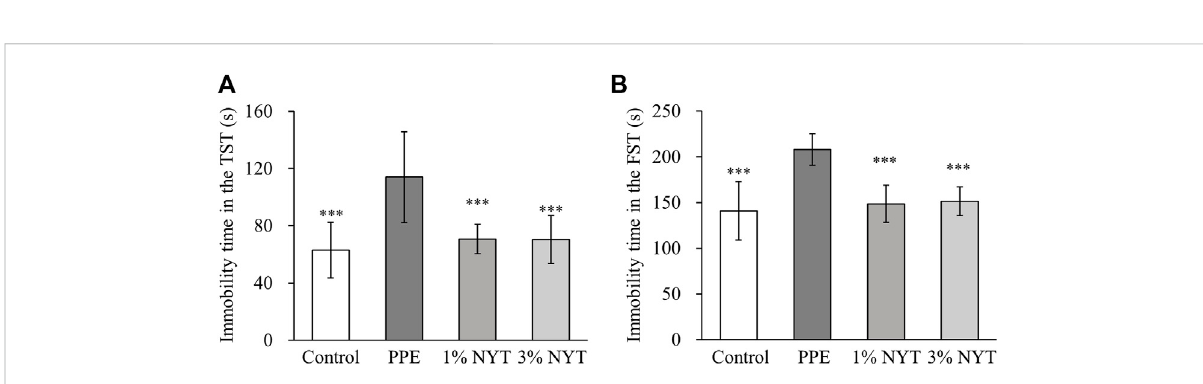
FIGURE 6 Effect of ninjin ’ yoeito (NYT) on PPE-induced depression-like behaviors. (A) Immobility time in the TST(s). (B) Immobility time in the FST(s). (Control n = 10, PPE n = 11, 1% NYT n = 8, 3% NYT n = 7). Values are expressed as means ± S.D. ppp p < 0.001 vs. PPE group by Tukey